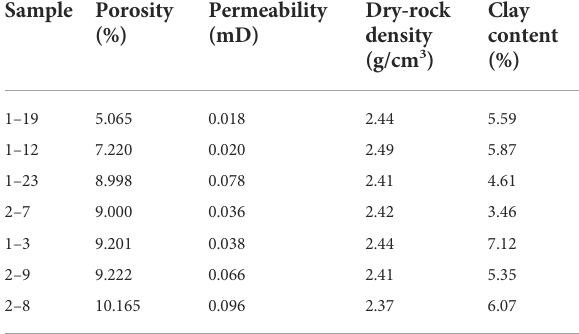
TABLE 1 Properties of the seven samples of the Yanchang formations.